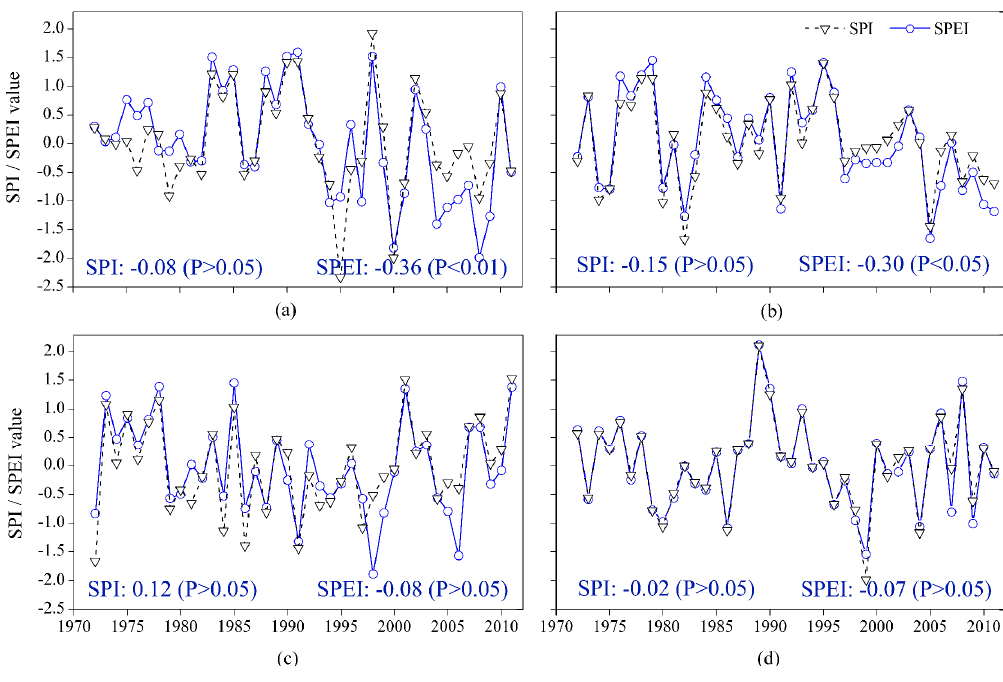
Figure 3. Variation in spring ( a ), summer ( b ), autumn ( c ), and winter ( d ) SPI and SPEI values at the 3-month time scale in Ningxia during the years 1972–2011 ( X -axis represents the year; blue font denotes the M–K trend per decade (including the statistical significance) in the SPI/SPEI